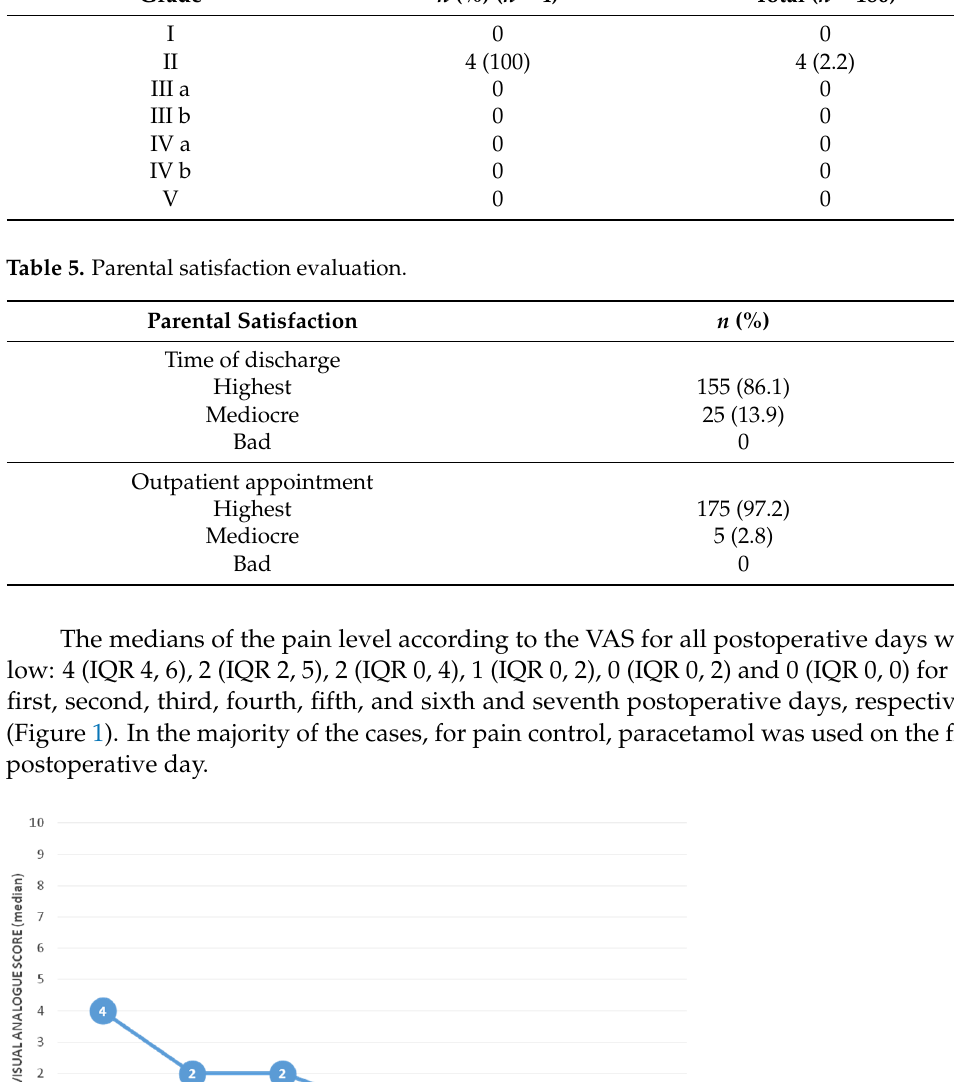
Table 4. Clavien–Dindo classification of postoperative complications.